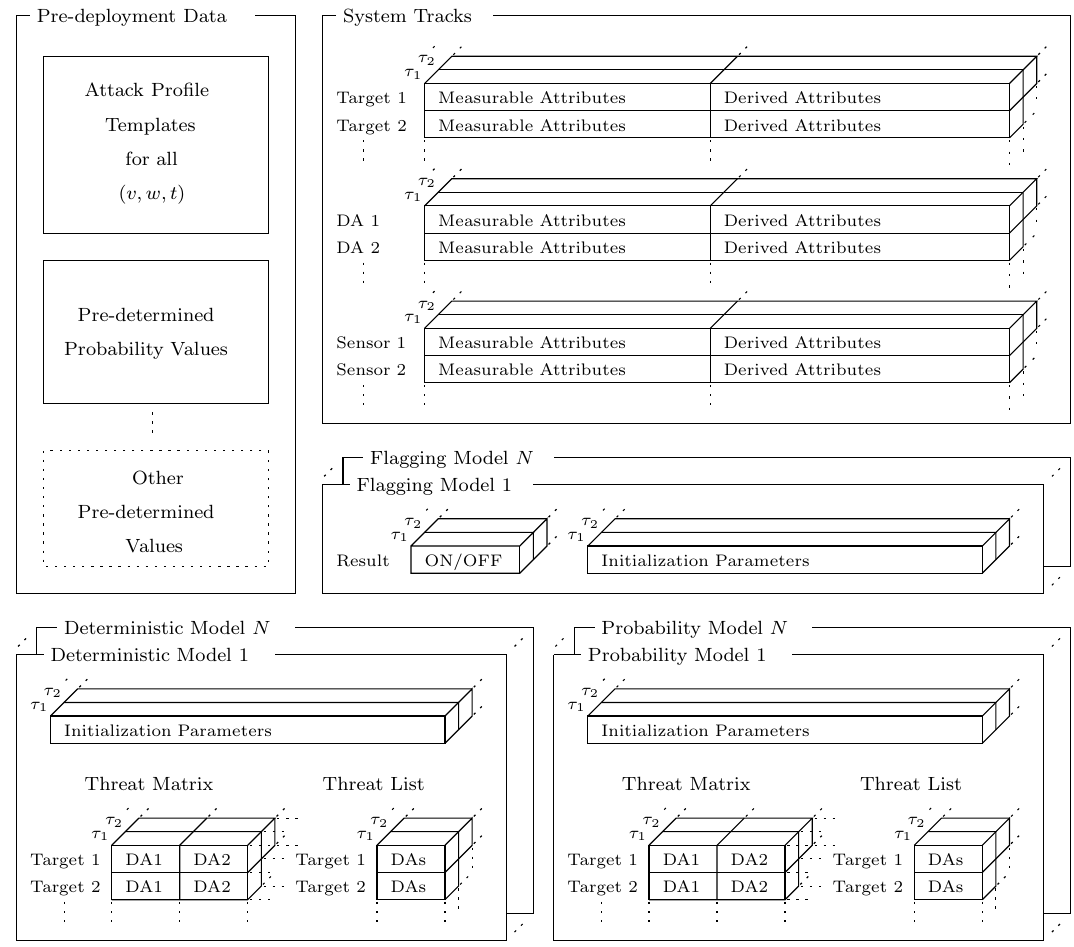
Figure 7: The TEWA database with focus on the TE-related